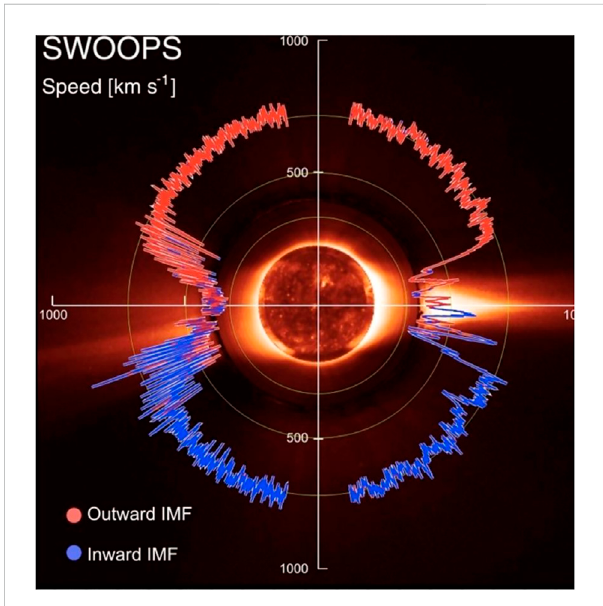
FIGURE 1 The solar wind speed distribution during the sunspot minimum condition (McComas et al. (2013).